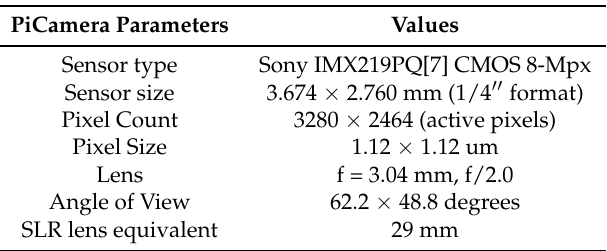
Table 2. PiCamera (v2.1 board) technical intrinsic